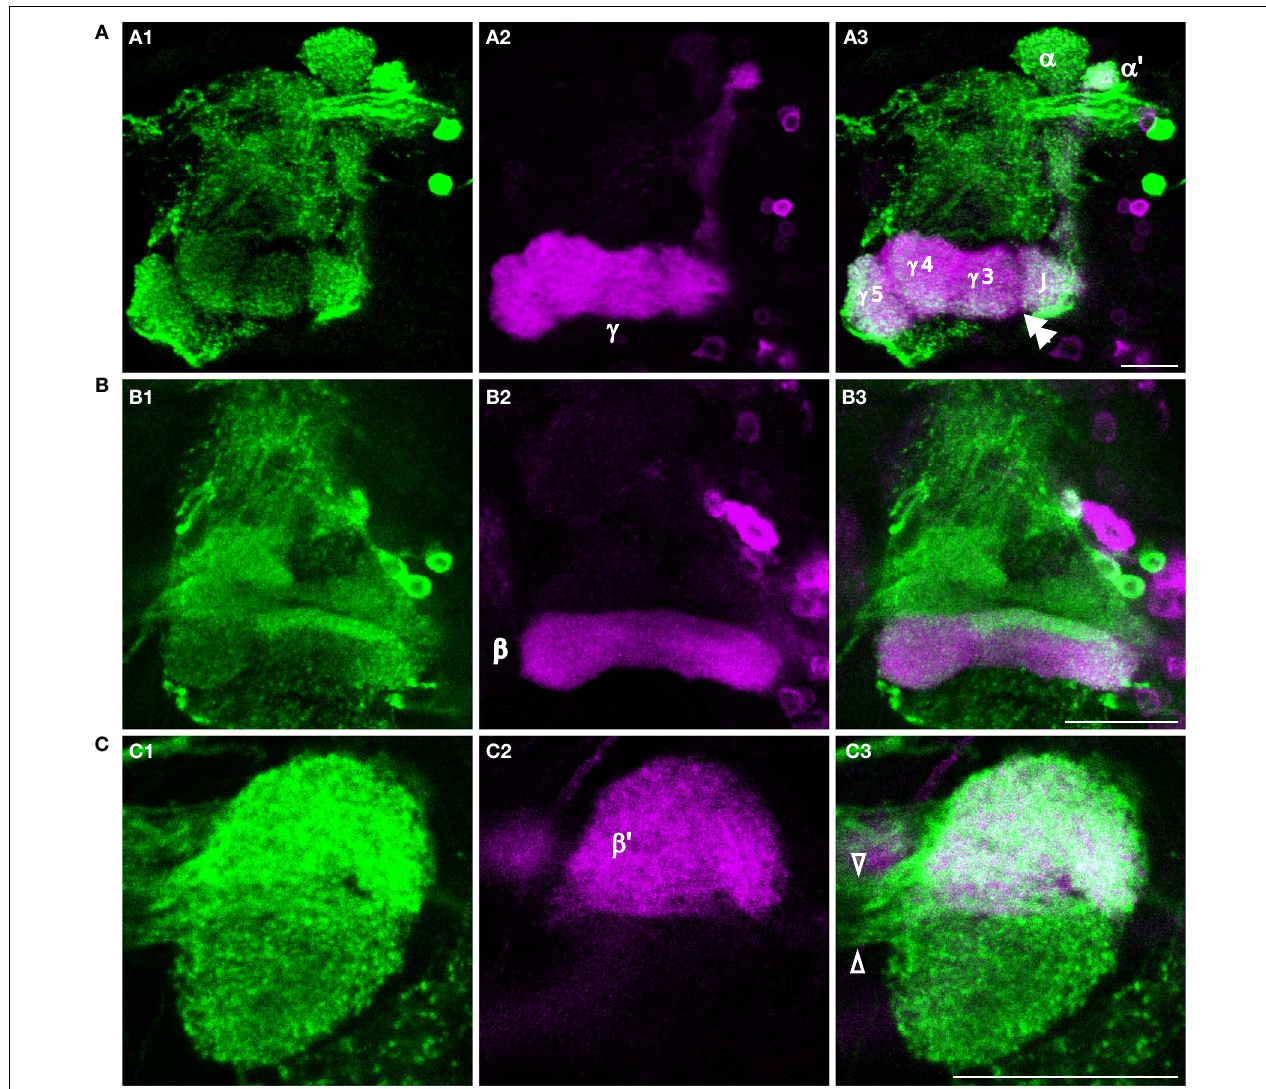
FIGURE 4 | Dopaminergic innervation of the horizontal lobes of the mushroom bodies. (A–D) Anti-TH immunostaining in the horizontal lobes. Maxiumum projection images of one hemisphere of frontal sections near the γ , β′ or β lobe. Medial is to the left; lateral to the right. Scale bar in all panels: 20 µm. (A1) Anti-TH immunostaining (green) of a brain from NP1131-GAL4>UAS-mCD8::GFP fl ies. (A2) Anti-GFP immunostaining (magenta) of the same brain. (A3) Merge of (A1) and (A2) . Note the discontinuous signal (double arrowhead) between the junction (J), and the medial segments of the γ lobe. This discontinuity in signal is also apparent in panel (A1) . (B1) Anti-TH immunostaining (green) of a brain from